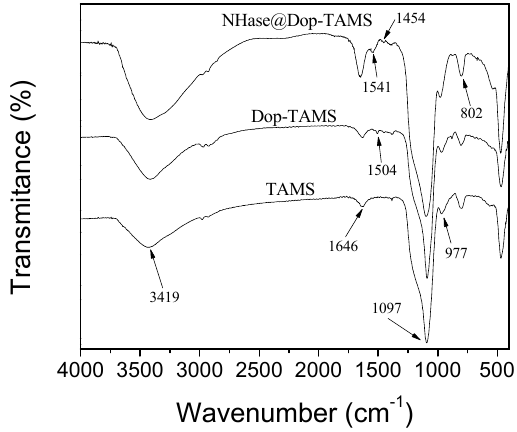
2 adsorption/desorption isotherms and pore size distribution of the Dop-TAMS. Molecules 2017 , 22 , 1597